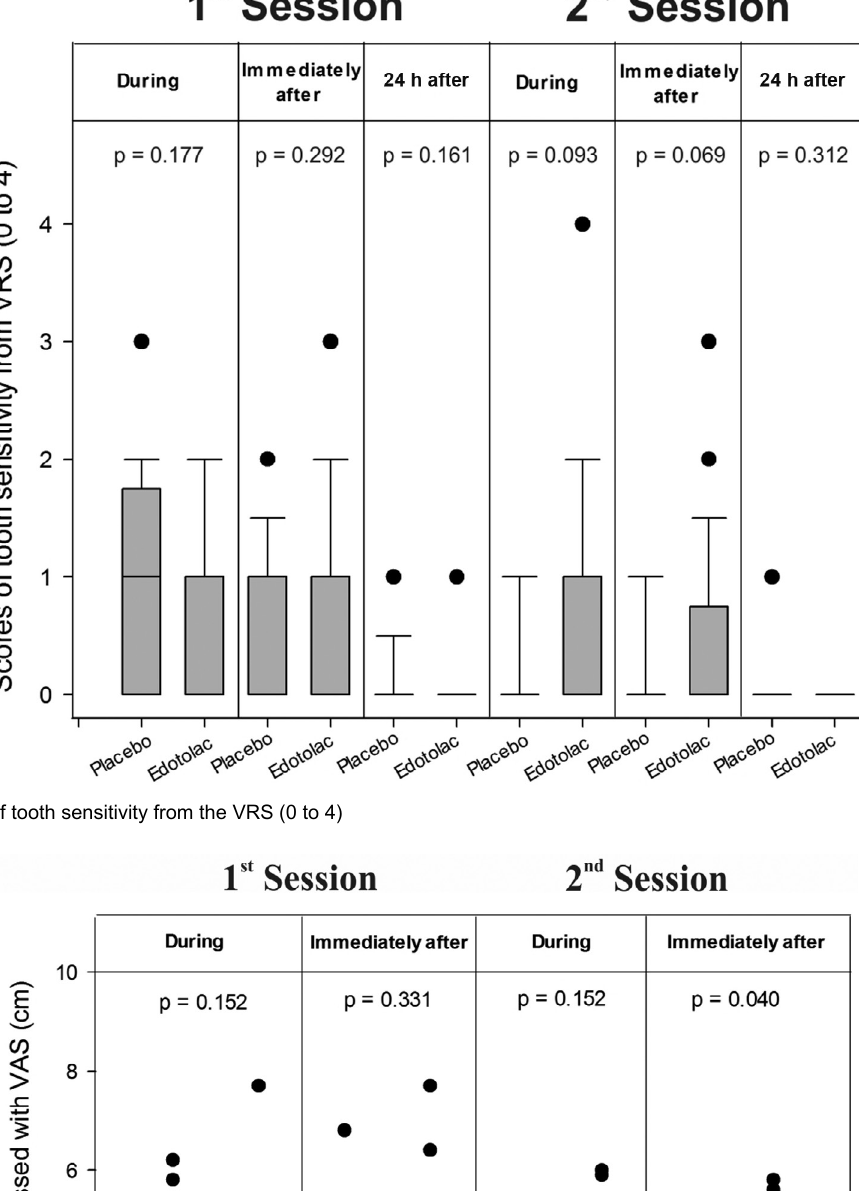
Figure 2 - Scores of tooth sensitivity from the VRS (0 to 4)